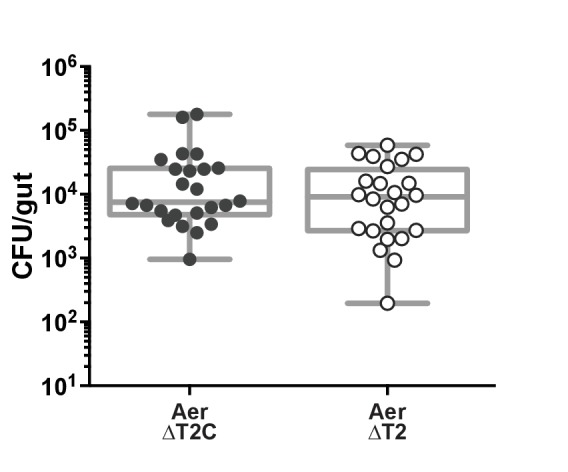
Colonization of A. veronii strain Hm21 type two secretion mutant.(A) veronii strain Hm21 isolates ΔT2, the type two secretion mutant, and ΔT2C, the compliment isolate with a wild-type phenotype, colonize the fish to similar levels. Each dot represents one fish. n ≥ 24, from two independent experiments.10.7554/eLife.37172.006Figure 1—figure supplement 1—source data 1.Colonization of A. veronii strain Hm21 type 2 secretion mutant.